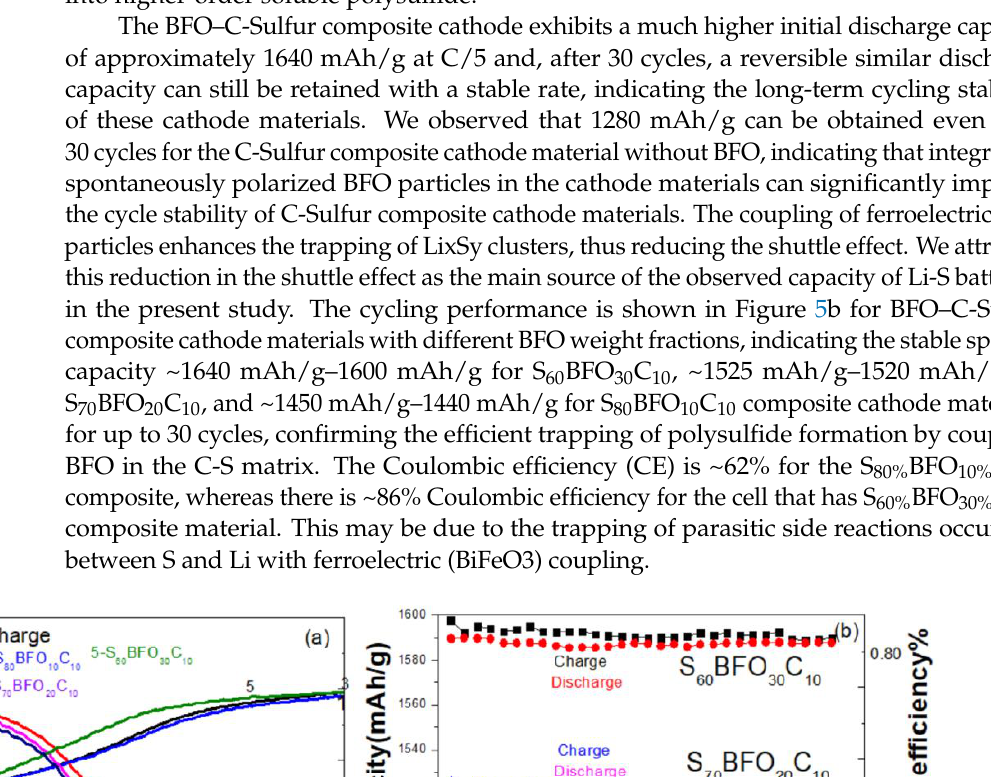
Figure 6. ( a ) C-rate versus discharge capacity and ( b ) Specific capacity versus specific current for BFO – C-Sulfur composite cathode materials.